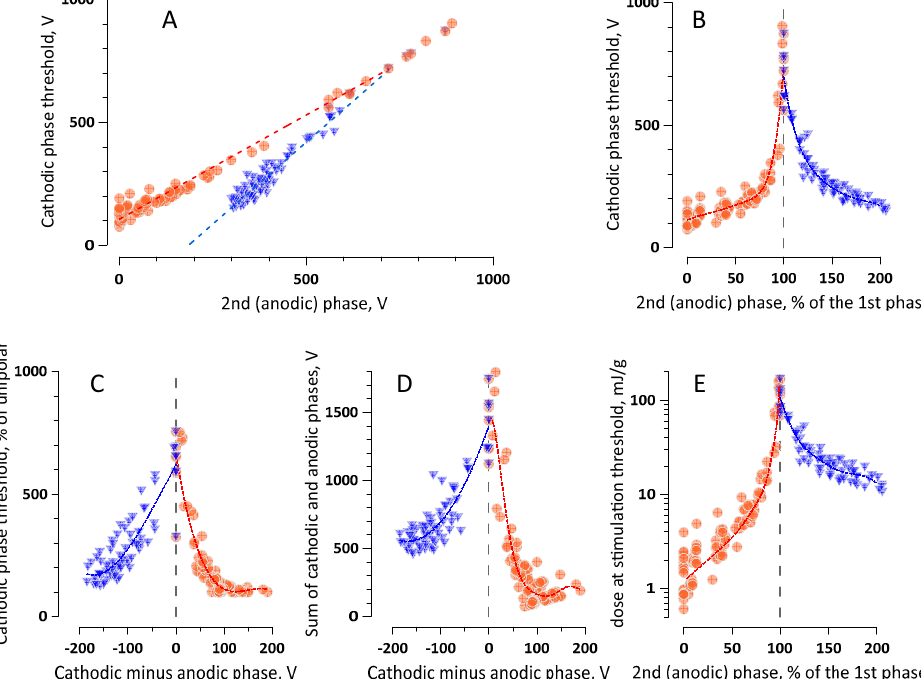
Figure 3. Nerve excitation by (600+600)-ns bipolar stimuli with different balance of the cathodic (1st) and anodic (2nd) phases, see text for details) Orange circles are the datapoints for the cathodic stimulation (larger 1st phase), and blue triangles are for the anodic stimulation (larger 2nd phase); the datapoints for symmetrical bipolar pulses were included in both groups. ( A – D) The impact of the 2nd phase amplitude ( A , B ) or the difference between two phases ( C , D ) on the cathodic phase threshold voltage ( A – C ) or the sum of voltages of both phases at the excitation threshold ( D ). ( E ) The absorbed dose at the excitation threshold for pulses with different ratios of the 1st and 2nd phases. The data are from 19 experiments in 4 nerve preparations. The dashed lines are linear fits in ( A ) and polynomial fits in the other